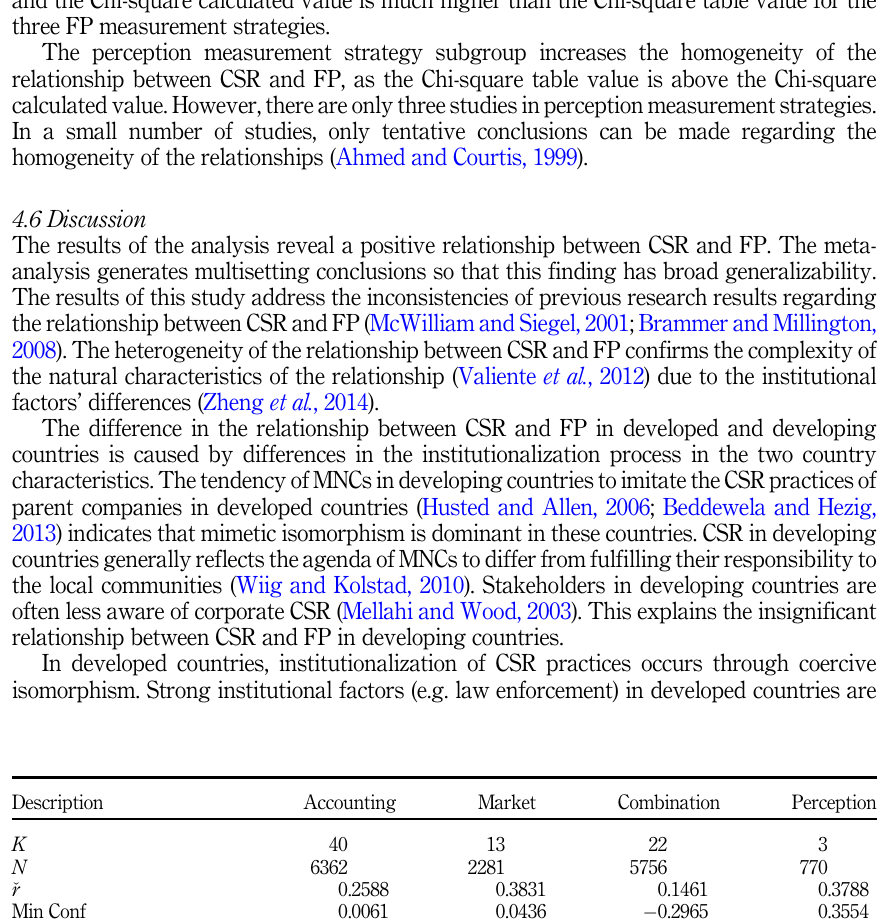
Table 6. Subgroup analysis – FP measurement